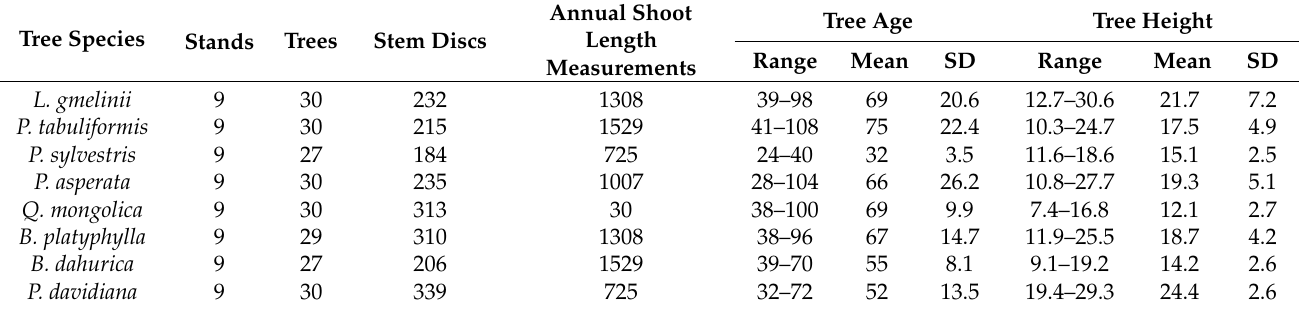
Table 2. Number of stands, trees, stem discs and annual shoot length measurements for each tree species and range of values, mean and standard deviation for tree age (yr) and tree height (m). Tree